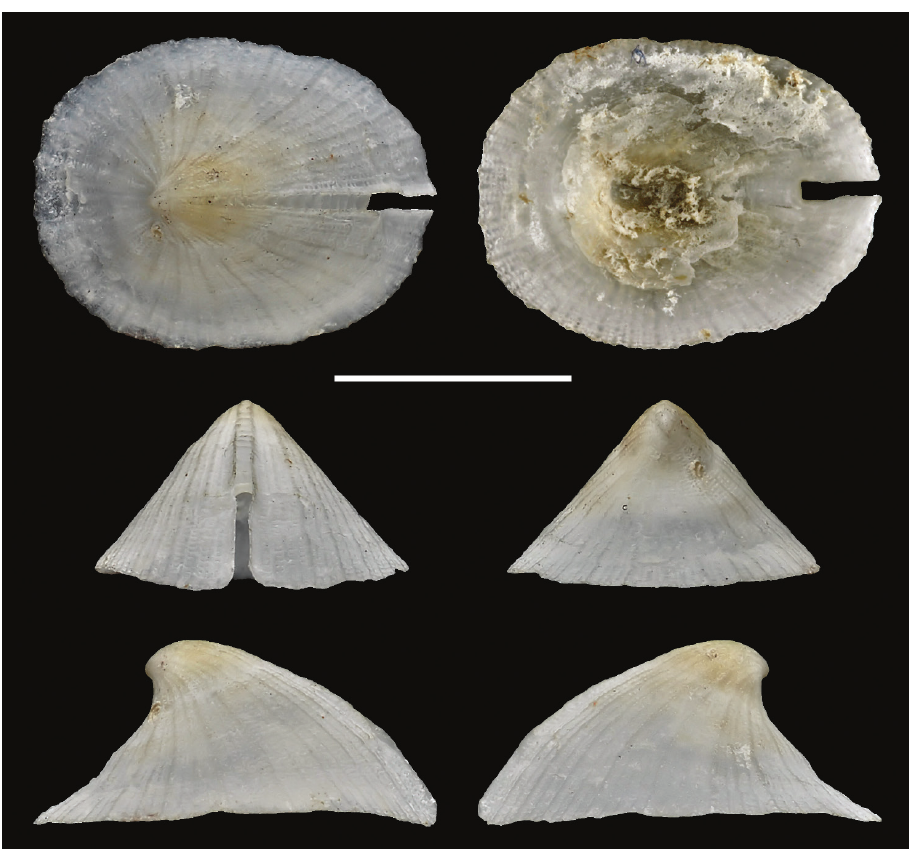
Figure 7. Emarginula mcclurgi Kilburn, 1978. Holotype T2190/NMSA-MOL 0A5726. Scale bar: 5